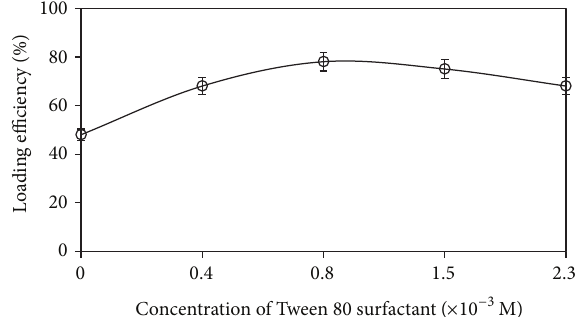
Figure 6: Effect of surfactant concentration on loading efficiency of curcumin onto starch nanoparticles.